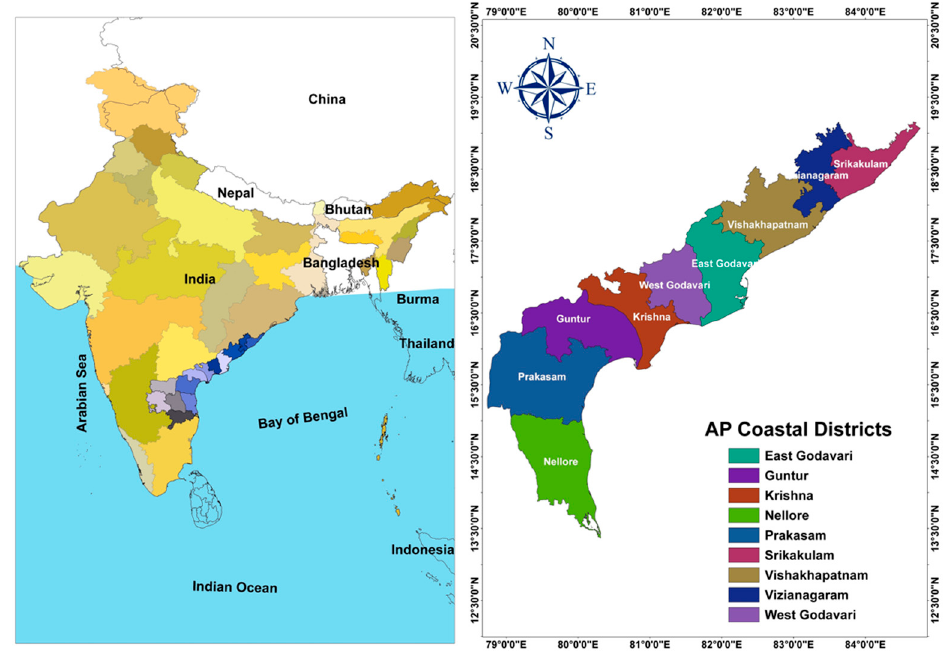
Figure 1. A spatial map of India with CAP indicated.